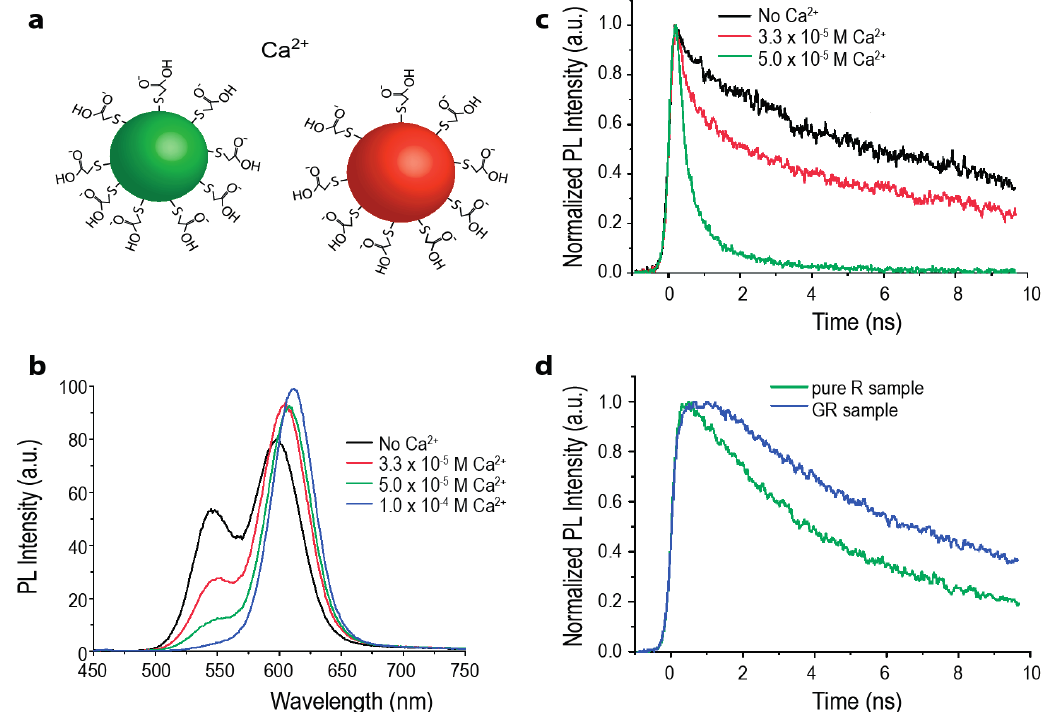
Figure 7. ( a ) Schematic of two-color QD-QD FRET Ca 2+ sensor. Green donor CdTe QDs and red CdTe acceptor QDs are each coated with thioglycolic acid (TGA), imparting a negative surface charge. In the presence of the calcium cation, the QDs aggregate, bringing them in close enough proximity for energy transfer to occur efficiently. Schematic is not drawn to scale; ( b ) The PL spectrograph shows a decrease in the green donor emission and increase in the red acceptor emission with increasing calcium cation concentration; ( c ) Time-resolved PL of the green emission with increasing amounts of calcium; as the cation concentration increases, QD-QD interactions are promoted. The donor emission lifetime visibly shortens, indicating that the green QDs are acting as FRET donors; ( d ) Time-resolved PL of deep red emission from red-only and green-and-red-mixed QD samples. In the presence of the green donor QD, the PL lifetime of the red emission is elongated; (b–d) reprinted with permission from [76]. Copyright (2008) American Chemical